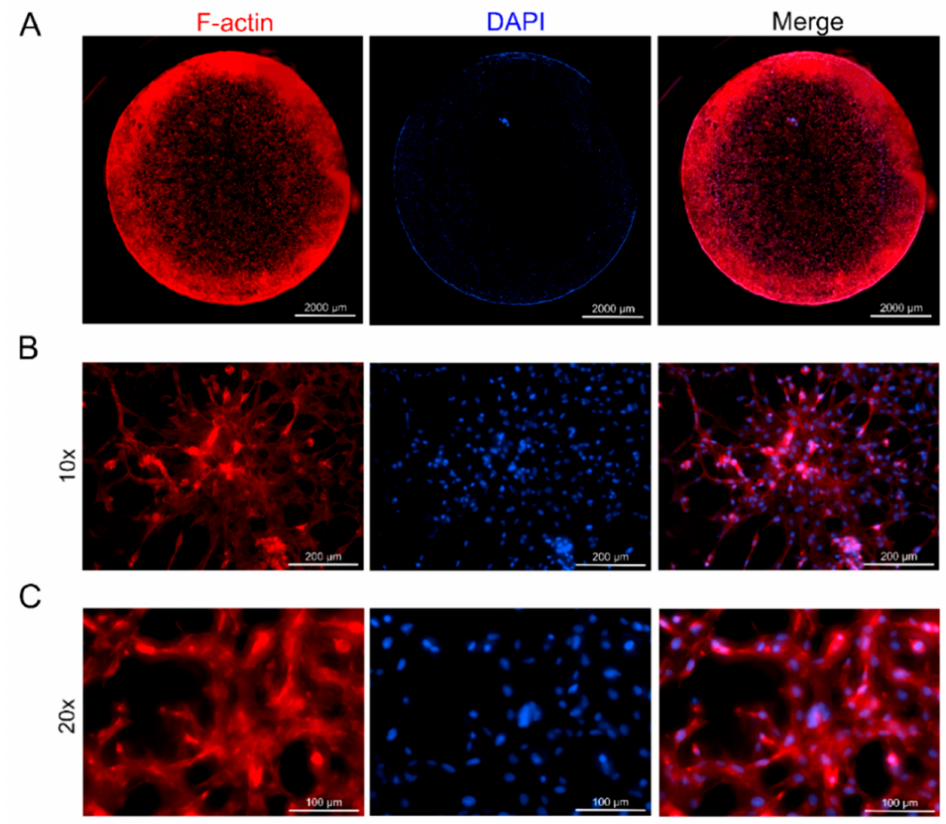
Figure 6. Phalloidin labeled F-actin (red), DAPI nuclear staining (blue) and overlaid fluorescent image of Z-stacked sca ff old (merged) for BEFCs on day 5. ( A ) Full image of the sca ff old sample. Scale bar = 2000 µ m. ( B ) 10 × magnification of sca ff old sample. Scale bar = 200 µ m. ( C ) 20 × magnification of sca ff old sample. Scale bar = 100 µ